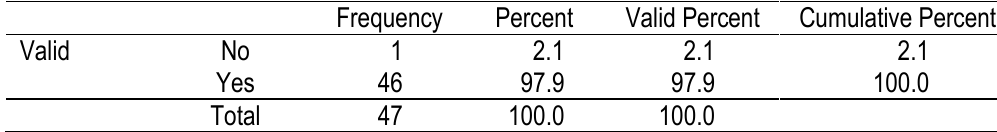
Table 3. “I think it is essential for a science course to include practical work even though the course materials are delivered in a distance mode of